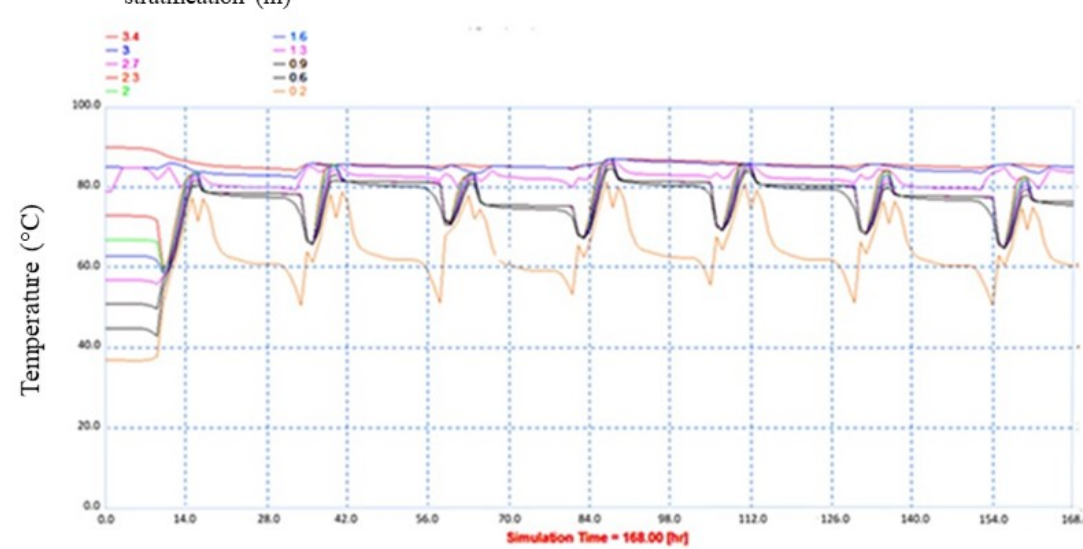
Figure 10. TRNSYS simulation for the summer season of the temperature stratification in the tank.